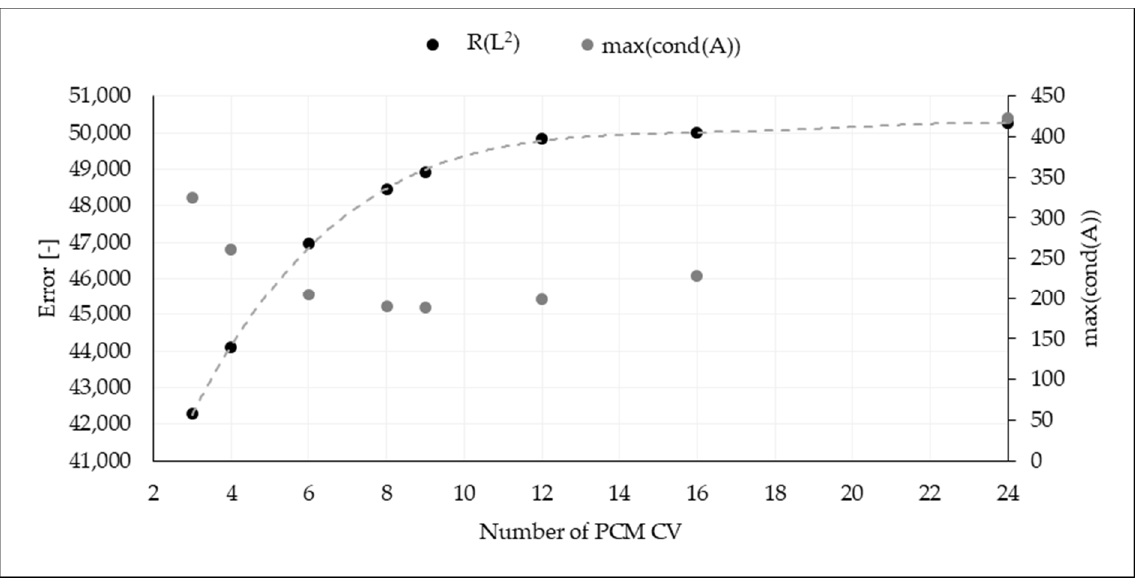
Figure 10. Analysis of the error R ( L 2 ) and maximal conditional value for different numbers of CV representing PCM.